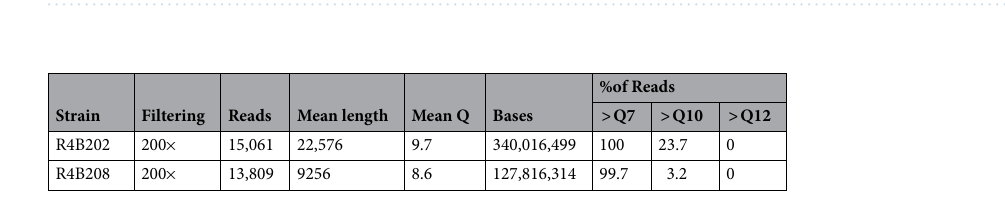
Table 5. Field Isolate MiSeq Data Summary. Sequencing metrics for two C. jejuni field isolates were determined using QUAST for MiSeq data.